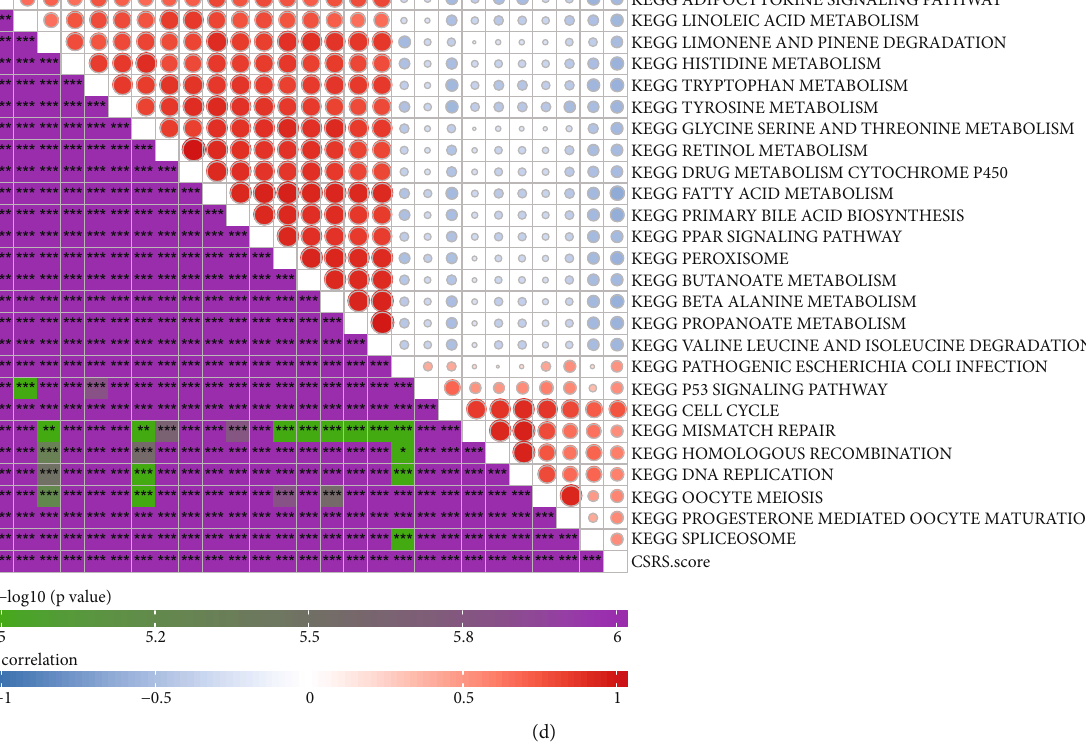
Figure 6: Immune and signaling pathways featured in high and low CSCR score subgroups. (a) Immune cells components and their proportion between high and low subgroups in the TCGA LIHC cohort. (b) Correlation analysis of proportion and CSCR score of 22 immune cells. (c) The CSRS and immune cells had signi fi cantly close relationship. (d) The low CSRS subgroup was profoundly enriched in the P53 signal pathway, cell cycle, mismatch repair, homologous recombination, and DNA replication. *P < 0.05; **P < 0.01; ***P <